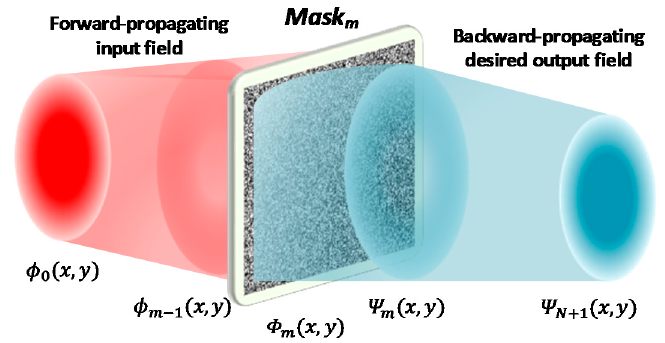
Figure 3. Schematic diagram of the wavefront matching method.